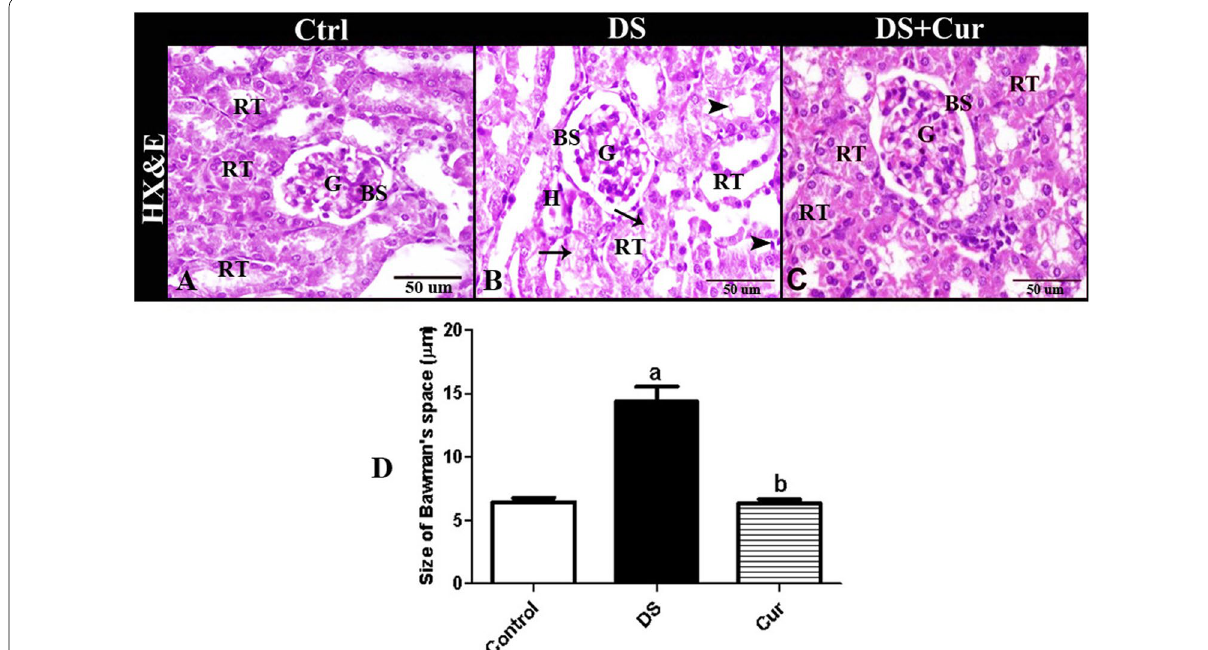
Fig. 3 Photomicrographs of paraffin sections stained with Hematoxylin and Eosin (HX&E) illustrated the protective effect of curcumin (Cur) on diclofenac sodium (DS) induced renal damage in rat. A The kidney of control (Ctrl) group showed normal‑sized glomerulus (G), Bowman’s space (BS) and renal tubules (RT). B The kidney of DS group showed small‑sized glomerulus (G) and wide Bowman’s space (BS) and renal tubules with mildly edematous epithelial lining (arrow), intra‑tubular cellular debris (arrowhead) and intra‑tubular hyaline casts (H). C The kidney of diclofenac sodium curcumin (DS Cur) group showed restoration of the normal size of the glomerulus (G), Bowman’s space (BS) and normal renal tubules + + (RT). Original magnification X400, scale bar 50 μm. D Histogram showed that the size of Bowman’s space significantly increased in DS group = compared to the control group, and oral supplementation of Cur restored the normal size of the Bowman’s space. Results are expressed as mean SEM (6 mice/group). Data are analyzed by one‑way ANOVA followed by Duncan posttest. a indicates significant difference between control ± and DS groups at p < 0.05; b indicates significant difference between DS and DS Cur groups at p < +